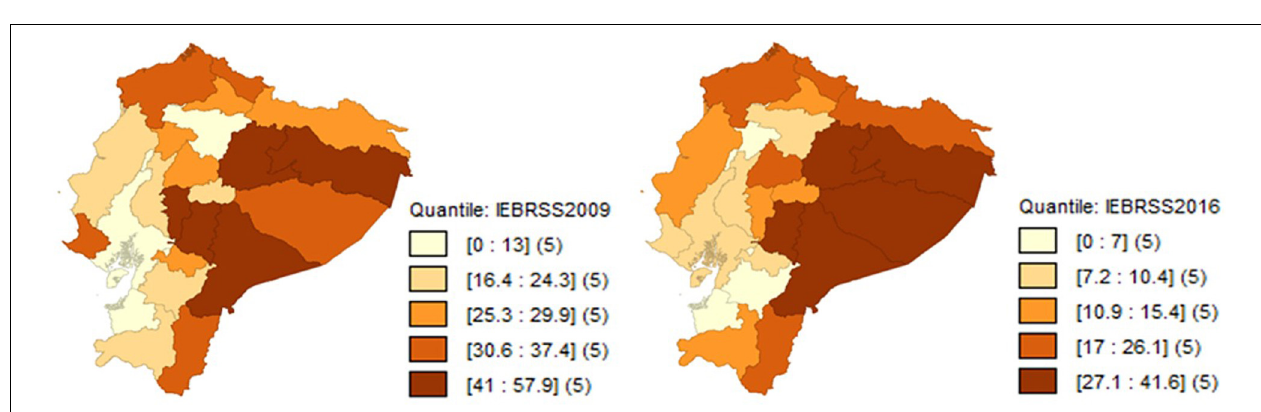
FIGURE 4 | Evolution of poverty by equivalent income with the IECK scale. Source: Own elaboration with data from ENEMDU 2009 and 2016.